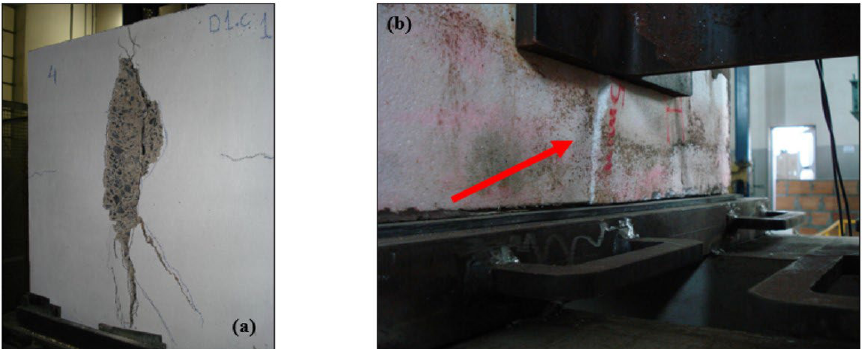
Figure 27. Typical cracking of concrete pry-out observed in tests: (a) D1 and (b)